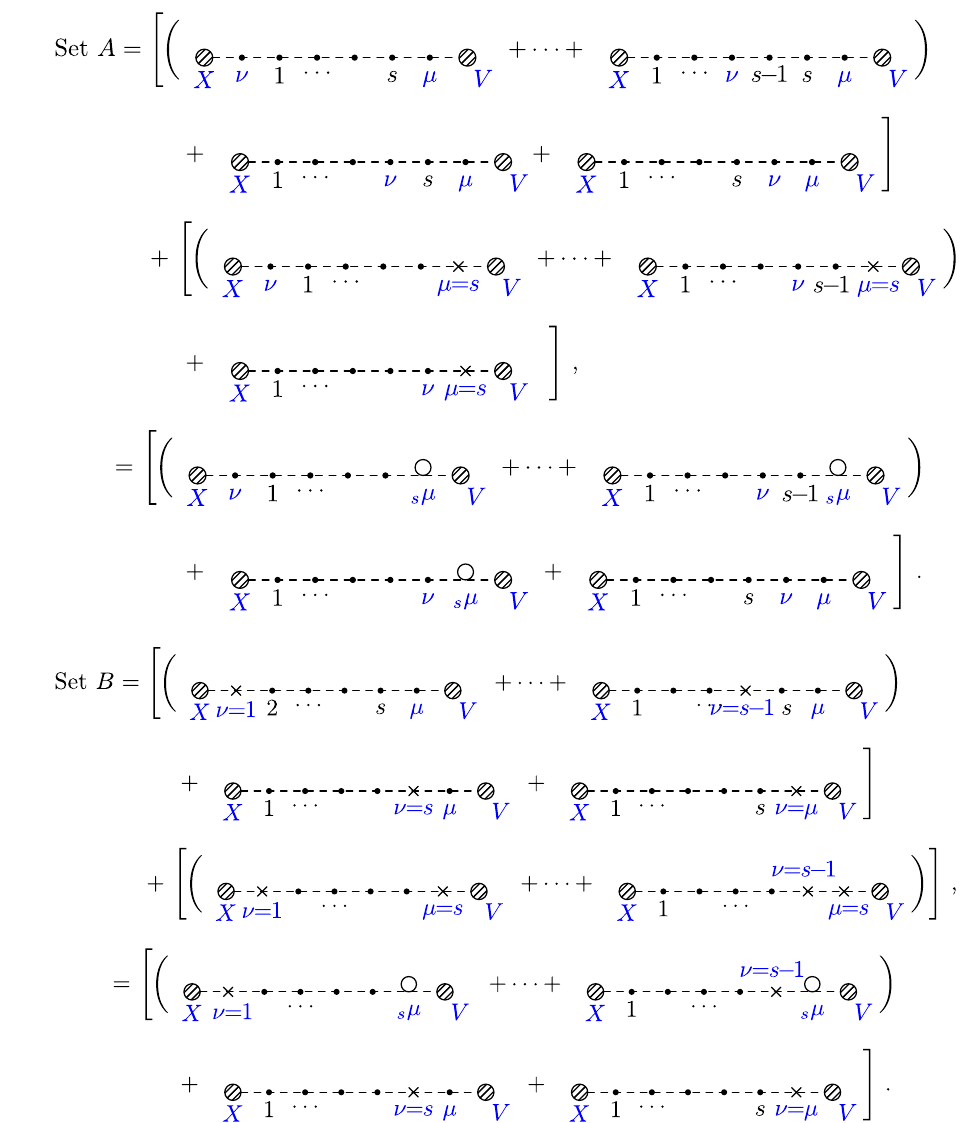
Fig. 10 Diagrams from Set A contributing to the ( n + 1 ) th matrix element when both vertices μ,ν of the ( n + 1 ) th virtual K photon are inserted on the intermediate scalar line.